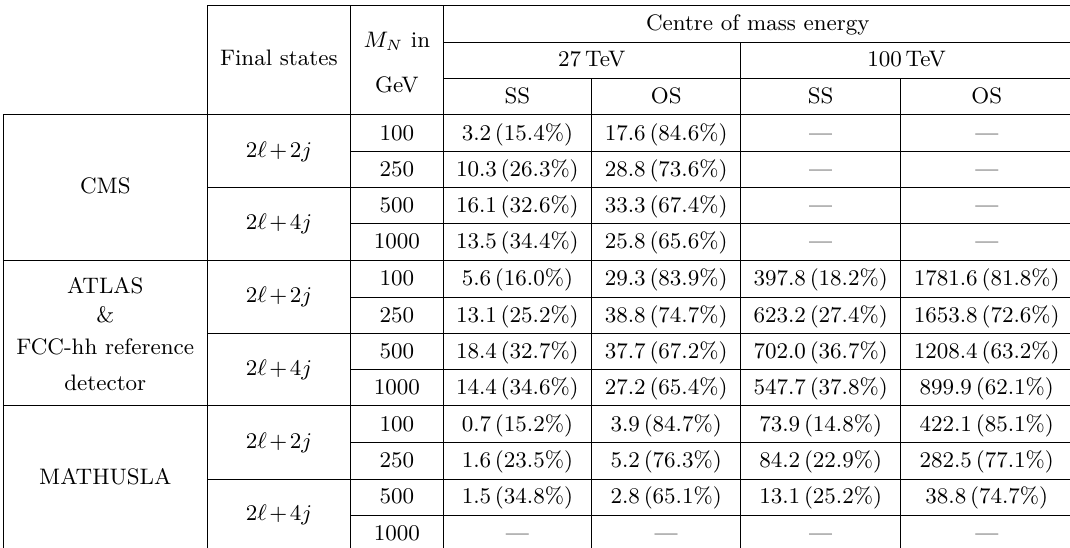
— — — Table 16. Number of events containing SS or OS and their percentage numbers (in bracket) for different RHN masses ( M in GeV) with the centre of mass energies of 27, 100 TeV, at the N integrated luminosities of 10 , 30 ab − 1 , respectively, and for Y = 5 × 10 − 9 . N Scenario-1 (section 3) deals with U with three generations of RHNs in Casas- PMNS √ Ibarra parameterization, where Y , that leads to relatively higher Y for higher ∼ M N N N mass values. In table 15 we present the number of events for 2 ‘ + 2 j final state for M = N 60 , 100 , 250 , 500 GeV. The events for M = 10 GeV are mostly outside the detectors i.e. N CMS, ATLAS, FCC-hh reference detector and MATHUSLA. Whereas, for M = 1000 GeV, N we get prompt leptons, which is not our interest for this article. M = 60 GeV, has N